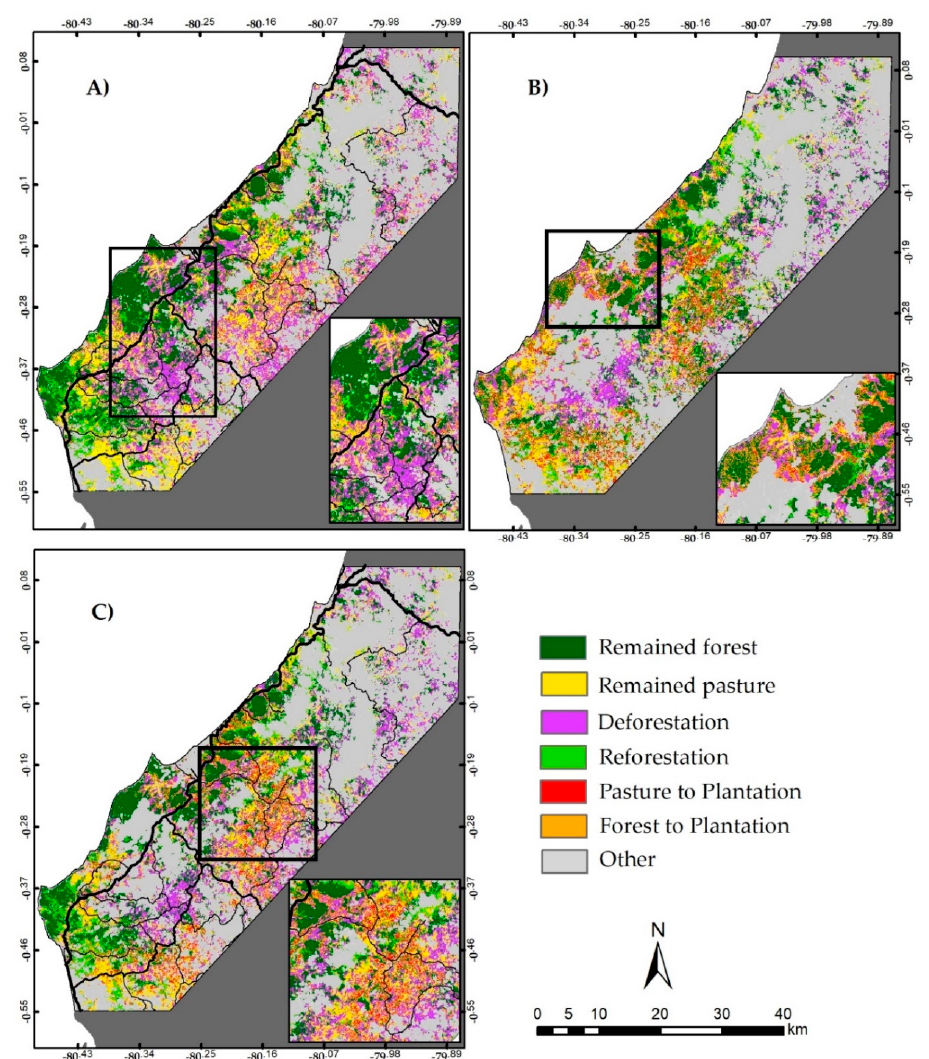
Figure 5. Change trajectory maps between: ( A ) 1990 and 2013-15 dry season, ( B ) 1990 and 2013-15 wet season, and ( C ) 1990 and 2013-15 bi-seasonal. Other includes areas of cloud, cloud shadows, and other transitions. Inset maps show locations of important transitions discussed in the text. Lines indicate primary, secondary, and tertiary roads.